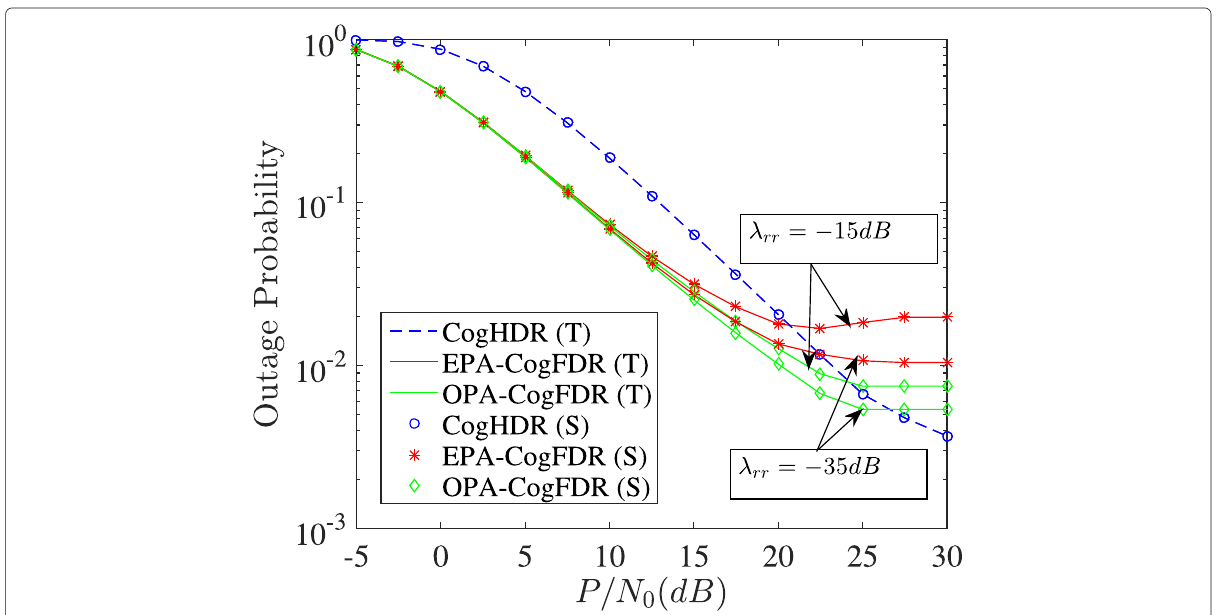
Fig. 6 Outage probability comparison with varying RSI; I avg / N 0 = 20